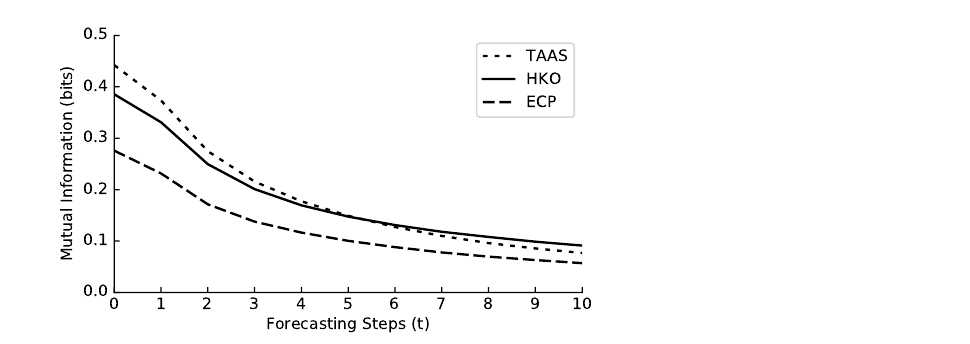
Figure 3. Mutual information of tasks with different forecasting lengths from three precipitation datasets.